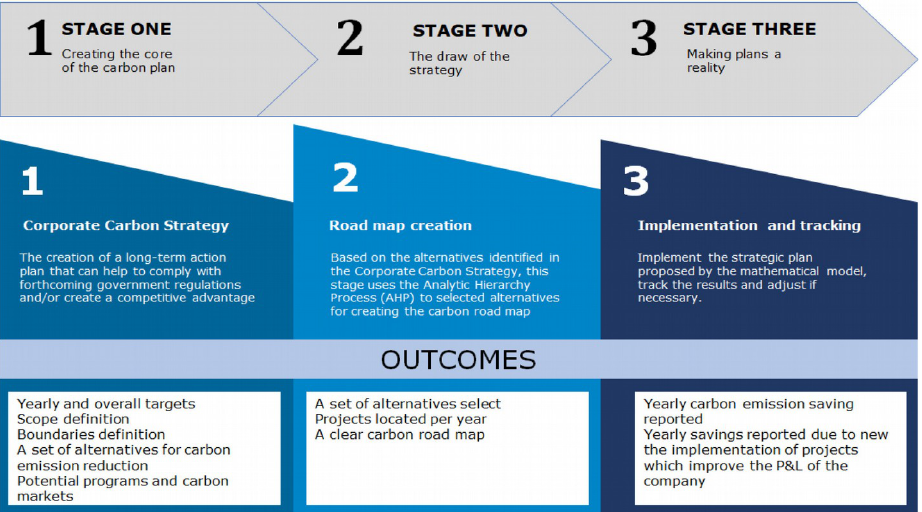
Figure 1. The three pillars of the Green Supply Chain Strategy